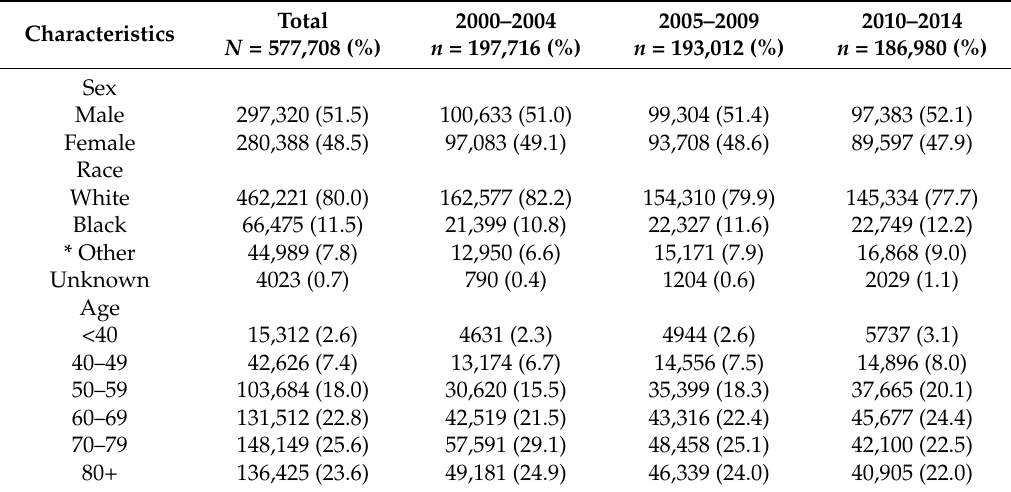
Table 1. Characteristics of colorectal cancer (CRC) cases by year of diagnosis (18 Surveillance, Epidemiology, and End Results (SEER) Program registries,